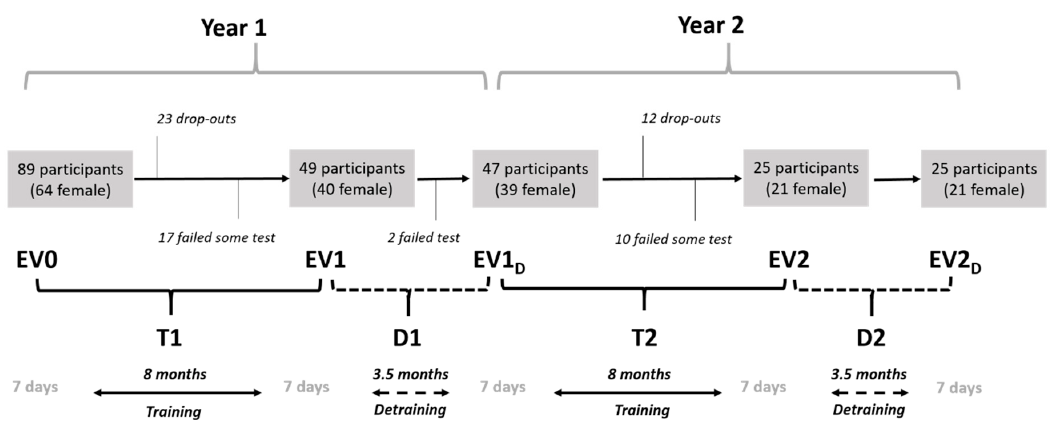
Figure 1. Experimental procedure and flow chart. T1 and T2: first and second training periods